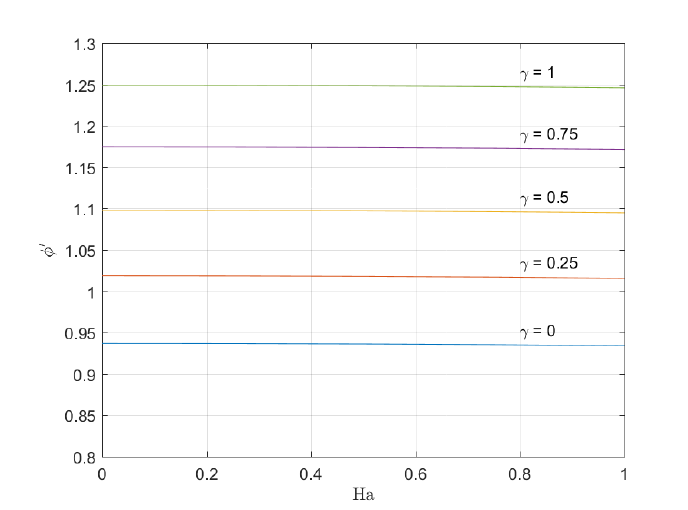
Figure 7. MHD and chemical reaction parameter effects on the rate of the chemical reaction in the boundary.